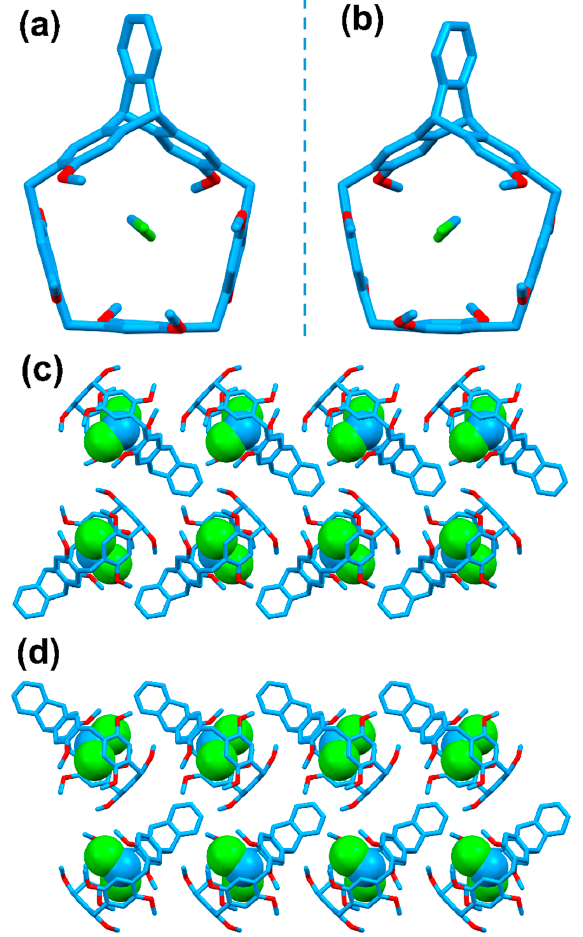
Figure 3. Crystal structures of ( a ) P - H , ( b ) M - H and packing mode of ( c ) P - H , ( d ) M - H along the c axis. Hydrogen atoms were omitted for clarity.